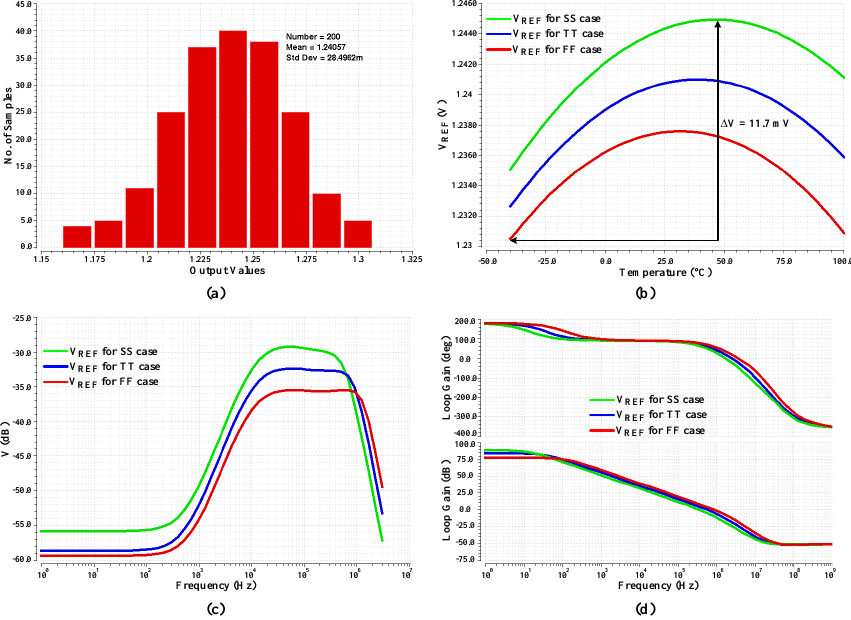
Figure 7. Post-simulation results of the proposed BGR. ( a ) Monte Carlo simulation. ( b ) Output voltage’s variation over temperature range. ( c ) PSRR for different corner cases. ( d ) Stability check.